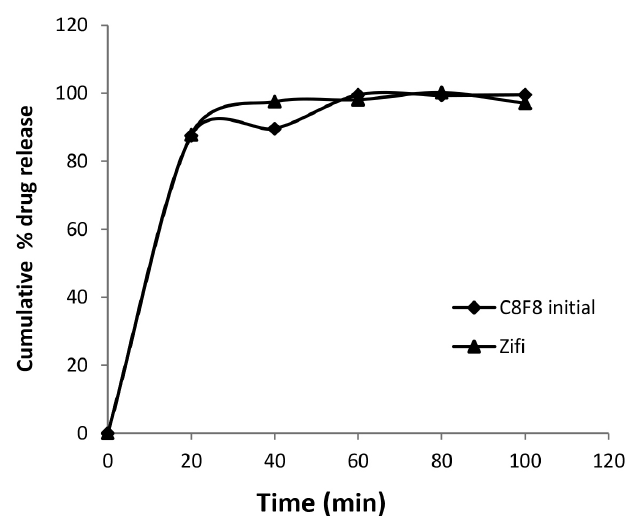
FIGURE 4 - Cumulative percentage of cefixime trihydrate released versus time (50 min) in pH 7.2 phosphate buffer, 900 ml at 100 rpm using USP type I dissolution test apparatus (mean ± SD, n= 6). C8F8 (Initial), data of initial condition and ZIFI 200, marketed reference